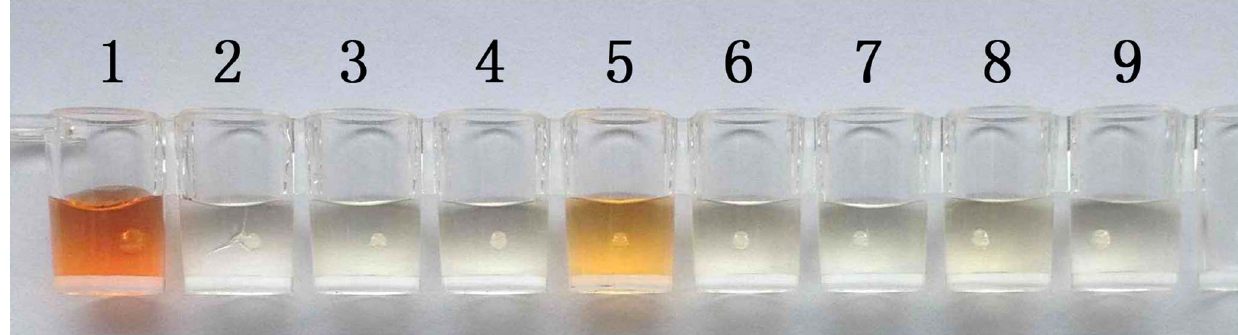
Figure 6. Identification of b -BuTx and B.multicinctus venom using aptamer b B-1 via ELAA. Snake venoms and proteins of 10 m g/mL were coated onto ELISA plate wells and incubated with 10 pM biotin-labeled aptamer b B-1, respectively. Then HRP-labeled Streptavidin was added and substrate OPD was used to achieve colorimetric responses. Control well was coated with b -BuTx but no aptamer was added. Well 1: b -BuTx; Well 2: a - BuTx; Well 3: BSA; Well 4: casein; Well 5: B. multicinctus ; Well 6: B. fasciatus ; Well 7: D. acutus ; Well 8: G. brevicaudus ; Well 9: